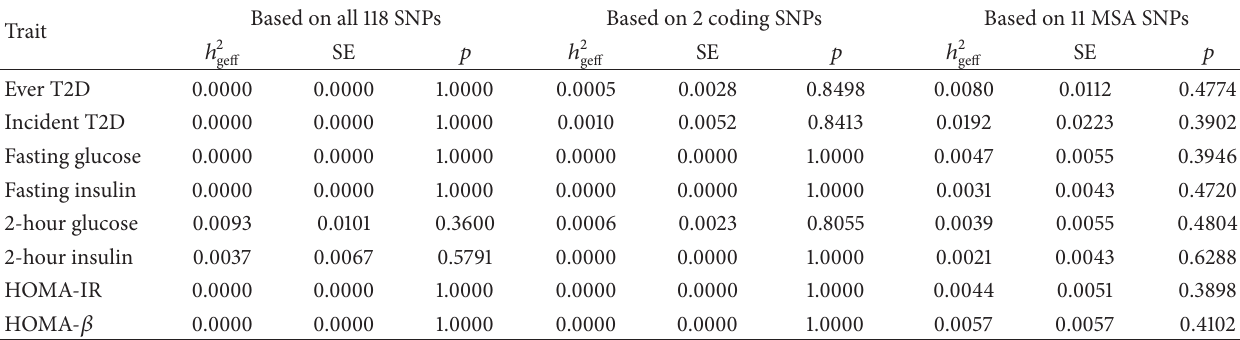
Table 4: Gene burden test for the association of the SLC30A8 locus with T2D-related traits.